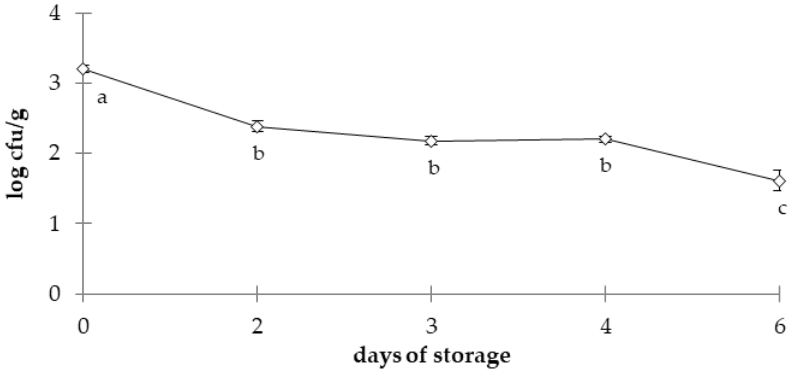
Figure 5. Counts of L. monocytogenes inoculated in cured loins stored at 6 °C for 126 days; bars indicate the standard error for each time; a, b, c means followed by different letters represent significant differences ( p <